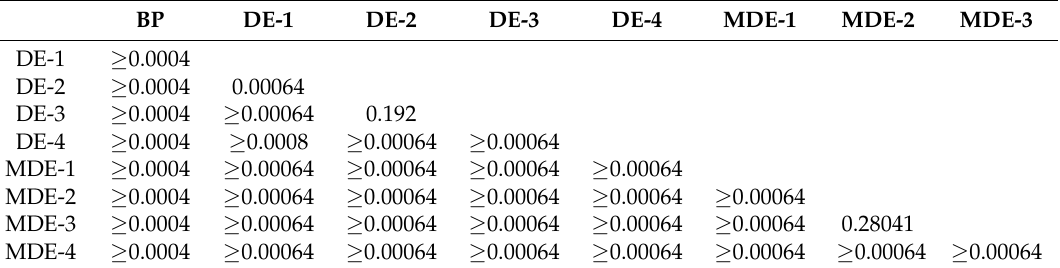
Table 15. Statistical test p -value of the Wilcoxon Sign Rank Test of results shown in Table